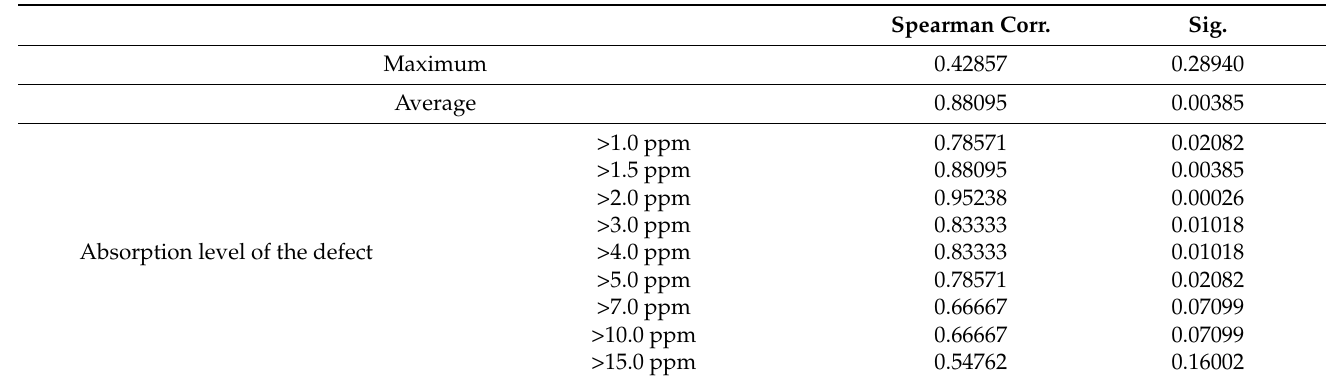
Table 5. Spearman correlation between damage densities at 8 J · cm − 2 and density of the defects with different absorption